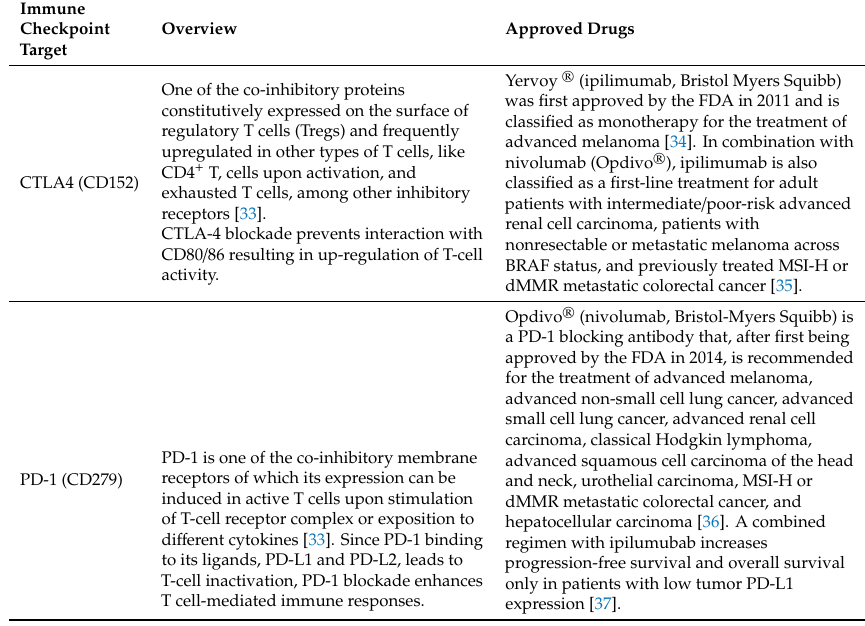
Table 3. Approved checkpoint inhibitors for cancer